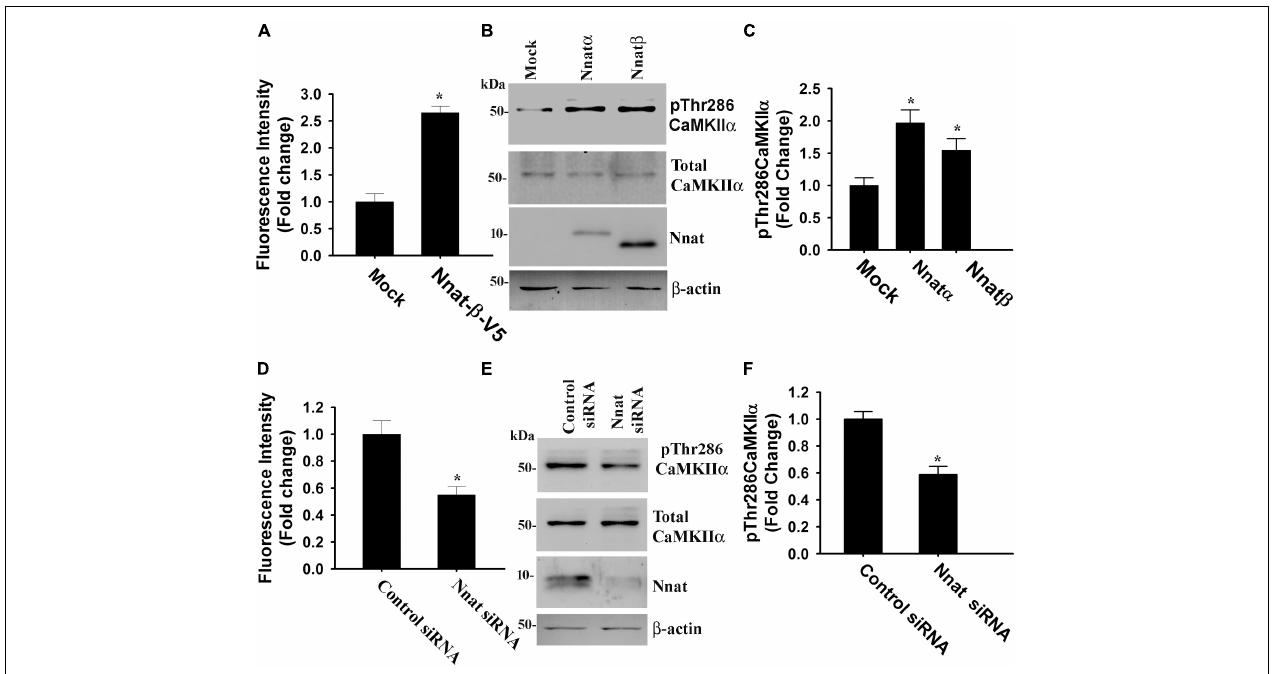
FIGURE 6 | Nnat modulates intracellular Ca 2 + homeostasis and the phosphorylation of CAMKII α at Thr286. HT22 hippocampal cells were transiently transfected with Nnat expression plasmids (Nnat α and Nnat β ) for 24 h and then cells were either subjected to Ca 2 + imaging experiment (A) or processed for immunoblotting using antibodies against total and Thr286 phosphorylated form of CaMKII α (B) followed by quantitation of Thr286 phosphorylated form of CaMKII α (C) . Over-expressed Nnat α and Nnat β were detected by V5 antibody. Neuro 2a cells were transfected with Nnat siRNA and 24 h post-transfection, cells were either subjected to Ca 2 + imaging (D) or processed for immunoblotting using antibodies against total and Thr286 phosphorylated form of CaMKII α (E) followed by quantitation of Thr286 phosphorylated form of CaMKII α (F) . About 50–60 randomly selected cells were assessed for measuring fluorescence intensity in Ca 2 + imaging experiment and the experiment was repeated twice. Immunoblotting experiment was repeated thrice. Values are mean ± SD. ∗ P < 0.01 compared to respective control